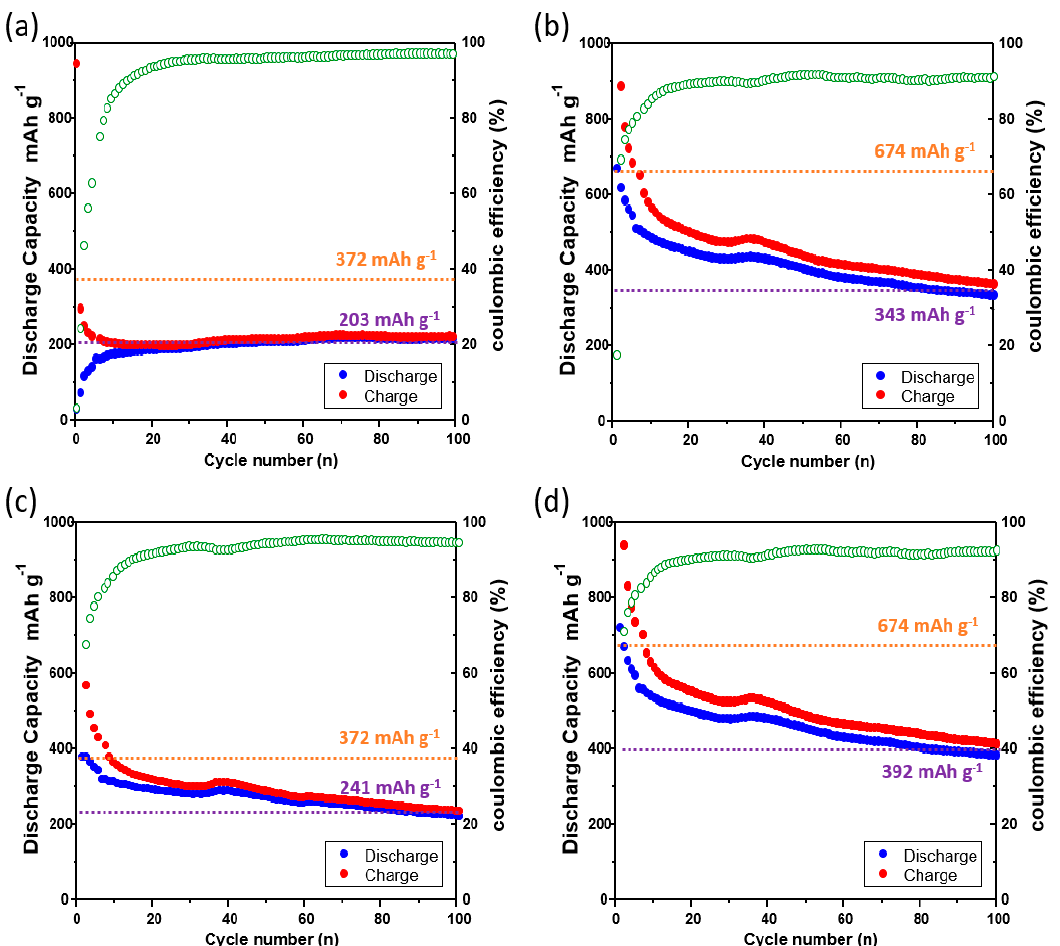
Figure 5. Charge–discharge graphs of the use of the four samples of the Cu current collector for the lithium-ion battery (orange dashed line: theoretical capacity, yellow dashed line: capacity after 100 cycles): ( a ) the charge–discharge curves of the bare Cu current collector when graphite is